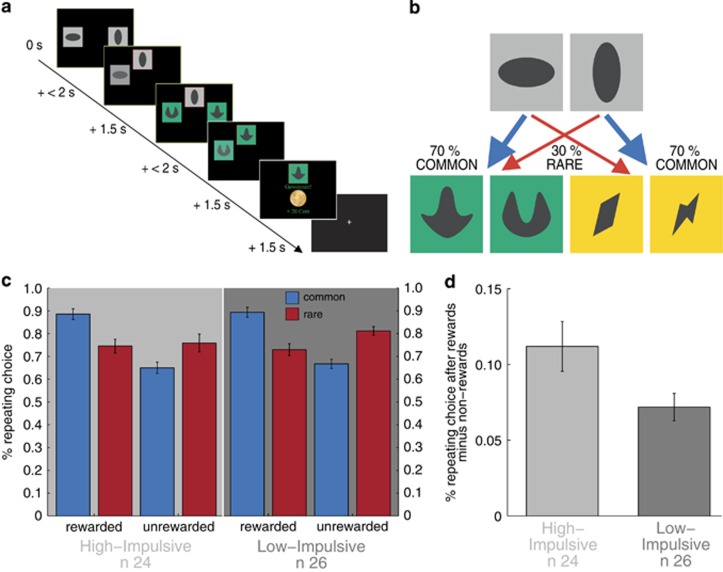
Task and behavioral raw data. (a) Exemplary trial sequence of the task. (b) State-transition probabilities. (c) Stay-switch behavior at the first stage was analyzed as a function of reward and state in the previous trial. These stay probabilities were subjected to repeated-measures analysis of variance (ANOVA) with reward and state as within-subject factors and group as between-subject factors. This revealed a significant main effect of reward (F(1,48)=75.30, P<0.001) and reward × state interaction (F(1,48)=64.30, P<0.001); no significant main effect of state (F(1,48)=1.32, P=0.26) and no significant state × group (F(1,48)=0.07, P=0.80) or reward × state × group (F(1,48)=0.73, P=0.40) interactions. There was a trend toward a significant reward × group interaction (F(1,48)=3.50, P=0.07). (d) In a one-tailed post hoc
t-test, the difference between staying after rewards and staying after non-rewards was significantly increased in the high- compared with the low-impulsive group (T(48)=1.94, P=0.04). Error bars represent s.e.